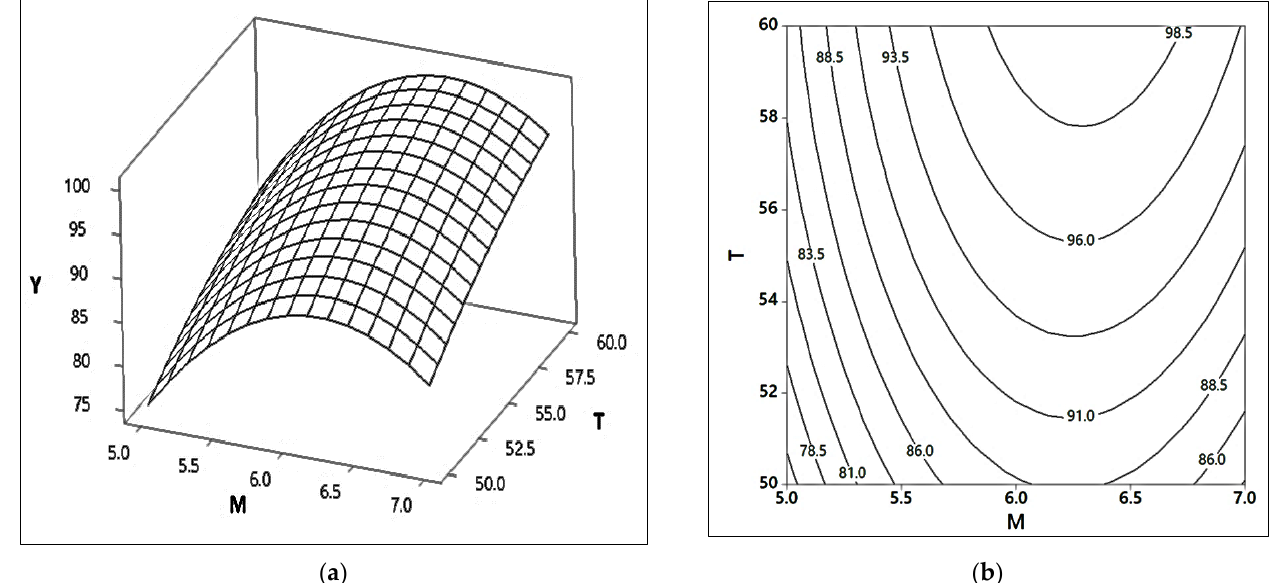
Figure 15. Interaction effect of the reaction temperature (T) and methanol to oil molar ratio (M) on the FAME yield (Y) of the transesterification process. ( a ) A 3D response surface plot of Y (%) vs. T (°C) and M (M). ( b ) A 2D contour plot between T (°C) and M (M).